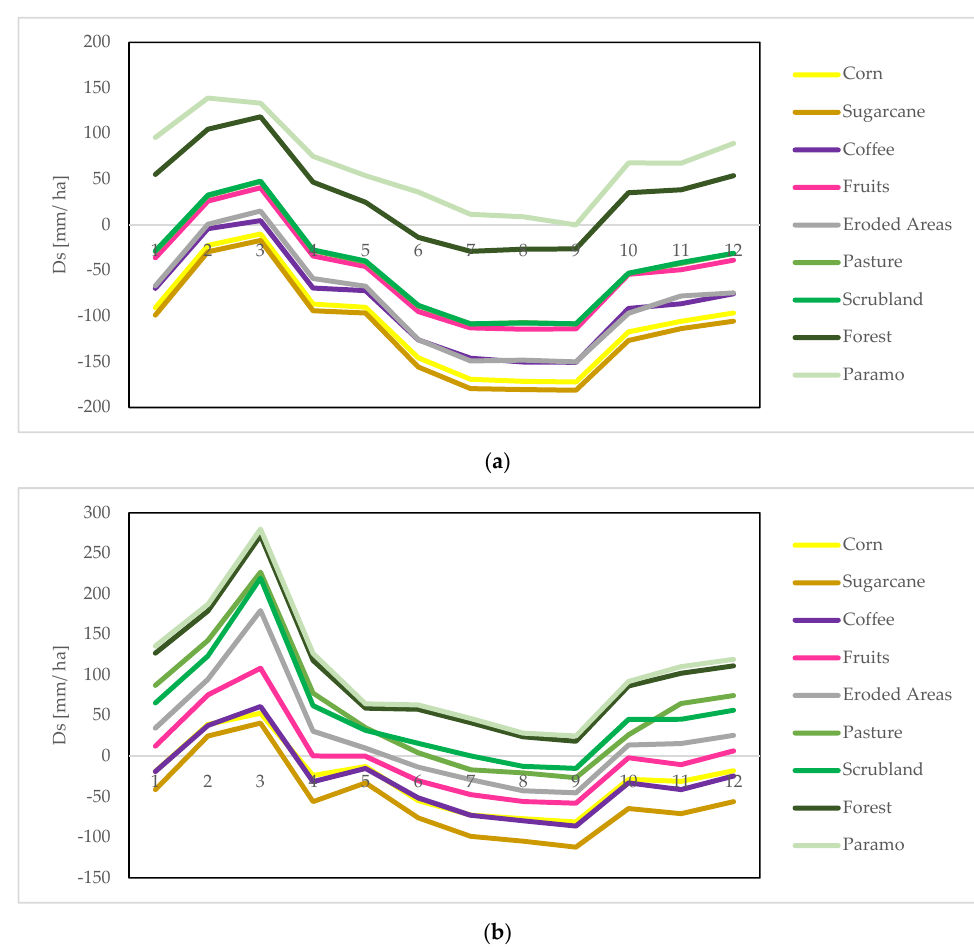
Figure 6. Monthly Ds [mm] for the different vegetation units present in the communities of Malacatos and Vilcabamba; ( a ) for lower elevation ( DsMin ) and ( b ) for higher elevation ( DsMax ).